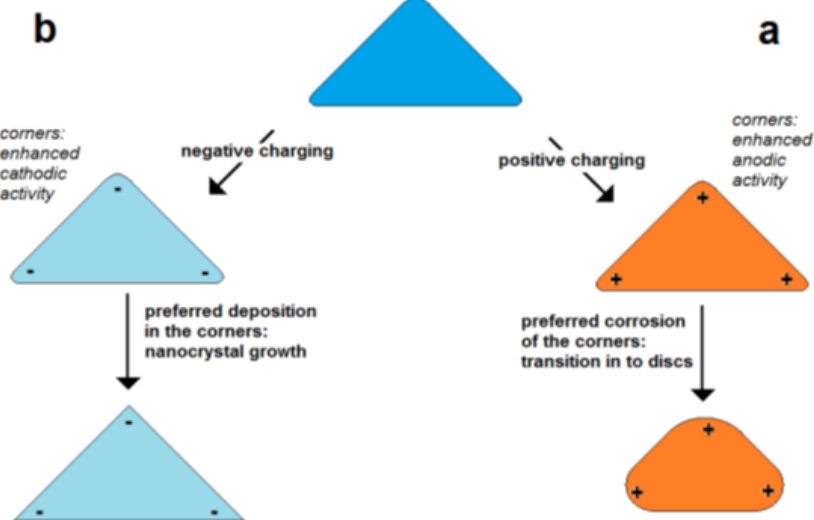
Figure 5. Self-polarization effect: effect of excess charge on the change of particle shape in depen- dence on charge sign shown for the example of a flat triangular metal nanoprism (schematically); ( a ) enhanced positive charge in the corners of triangular particle, ( b ) enhanced negative charge in the corners of particles